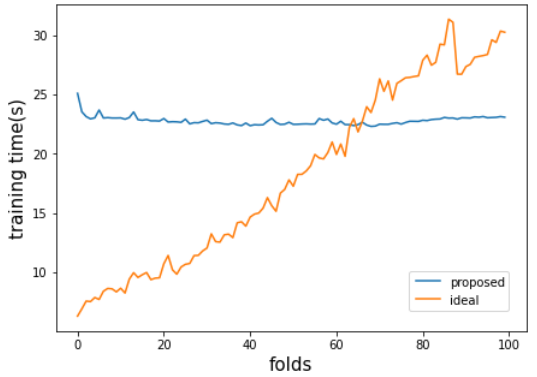
Figure 10. Training time per unit data input of the proposed method and the ideal method when the size of the pure dataset is 40,000 and the proportion of attack data is